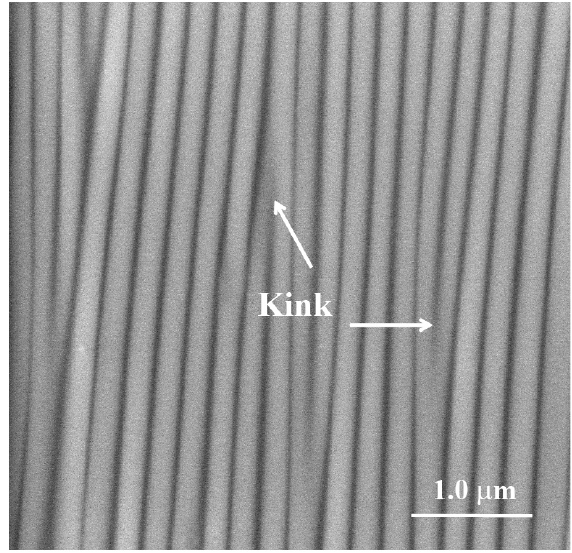
Figure 2. Scanning electron microscopy (SEM) image of the stretch induced surface wrinkles generated on the poly(dimethylsiloxane) (PDMS) substrate. The defects are visualized here as the sharp kinks between neighboring wrinkles. The SEM image was taken at 10 KeV, spot size 3 (1.7 nm), 50.000×